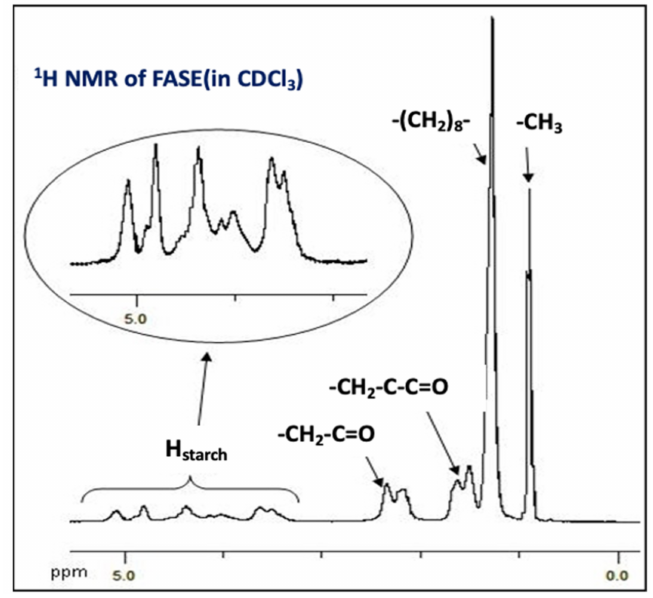
Figure 2. 1 H NMR spectrum of FASE (in CDCl 3